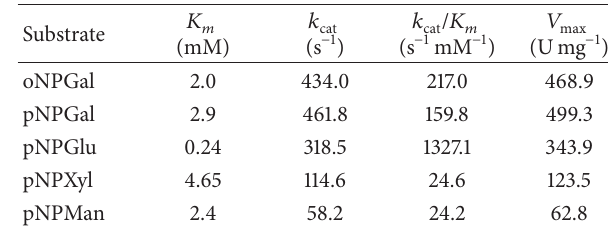
Table 2: Kinetic parameters of Asac